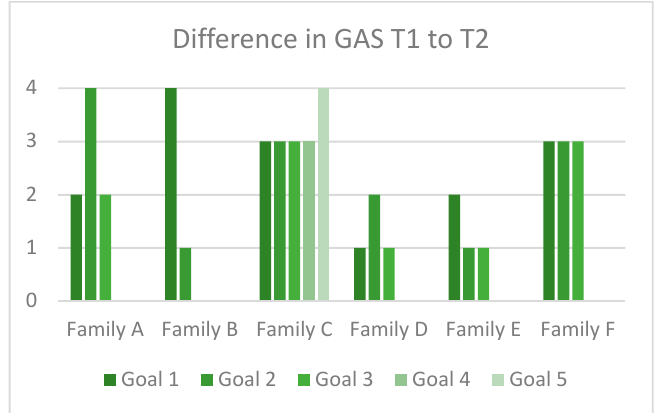
Figure 4. Goal attainment scaling on each goal per family, measured by the GAS change from T1 to T2. A positive number means that the goal was achieved. For family B, one goal had no progress on the GAS and is not visible in the figure. Table 4. Working alliance, usefulness and evaluation of SMART-goals and strategies, scale from 0 (“Completely disagree”) to 4 (“Completely